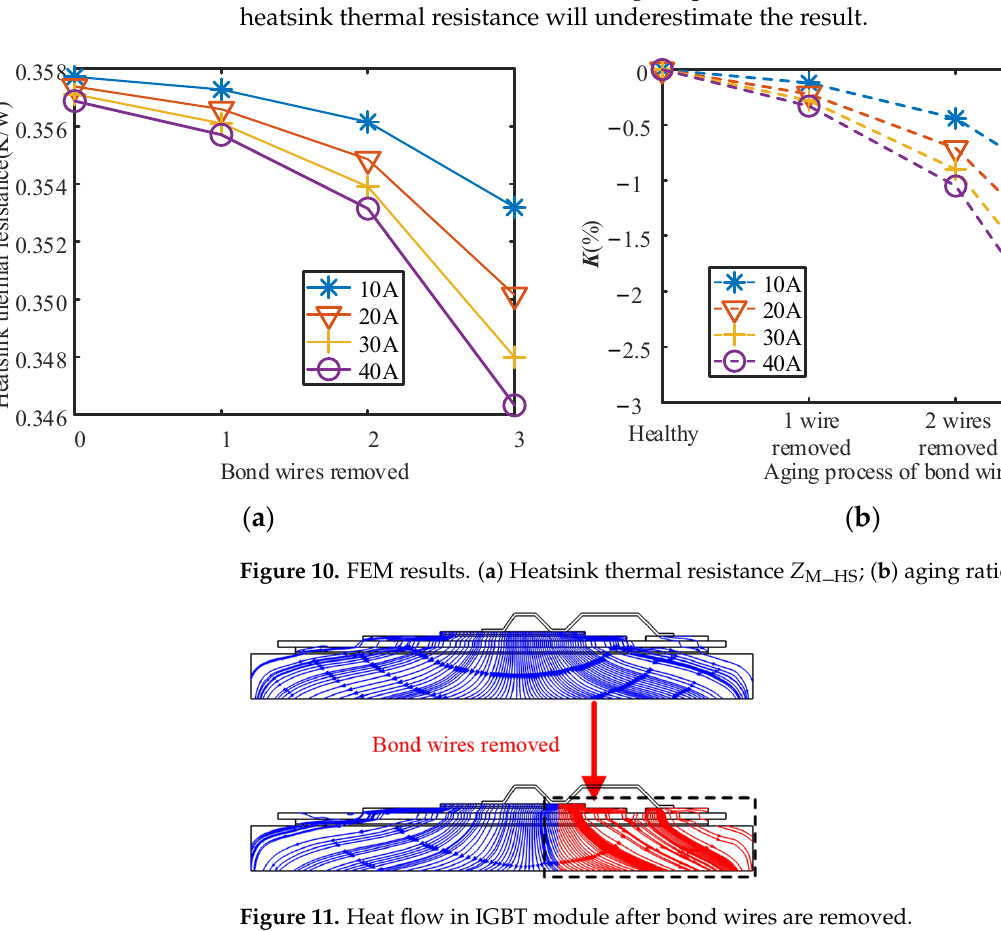
Table 3. Proportion of bond wire power loss in total loss.